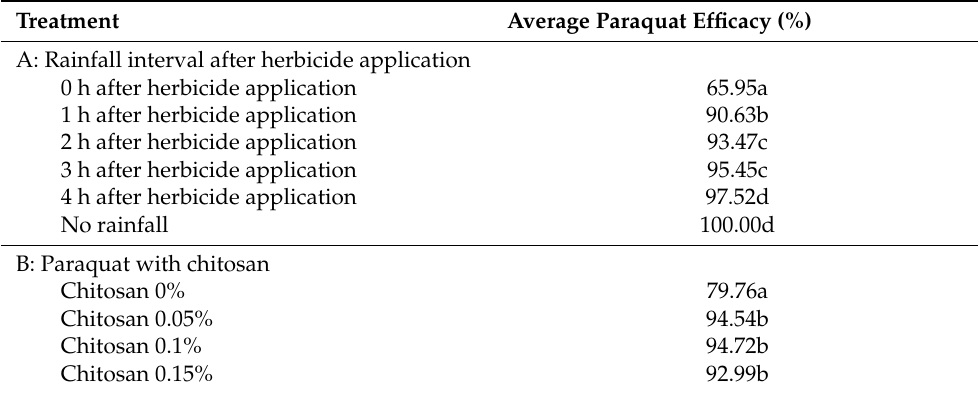
Table 2. Effect of simulated rainfall on herbicidal efficacy of a mixture of paraquat and chitosan against Paspalum conjugatum at different time intervals after mixture application.